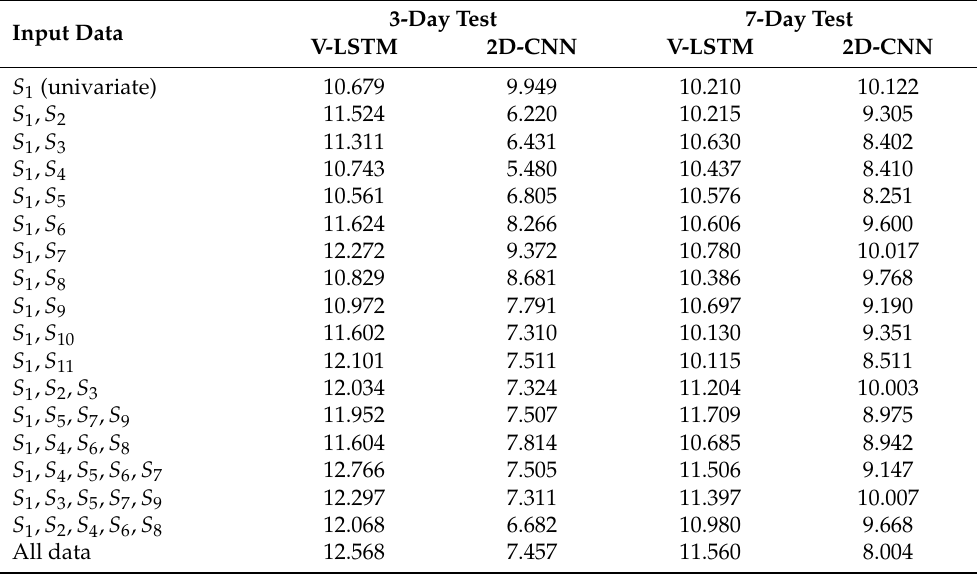
Table 7. Average RMSE for September 2018 tests, carried out by using V-LSTM and 2D-CNN models and different combinations of time series.